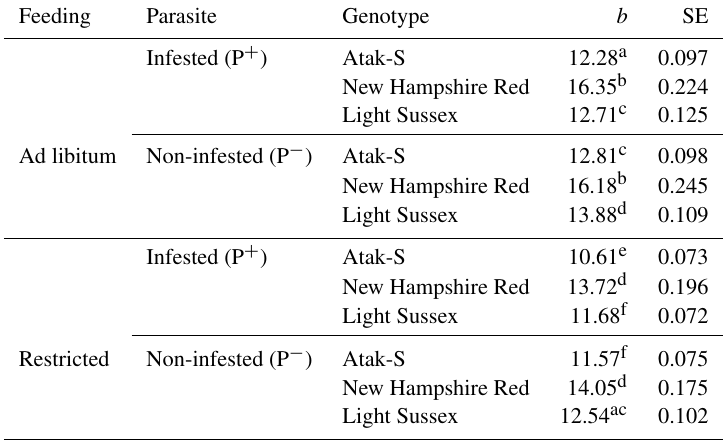
Table 3. Regression coefficients ( b , g) and their standard errors (SEs) showing the slopes of the weekly live weights according to feeding level and parasite effects.